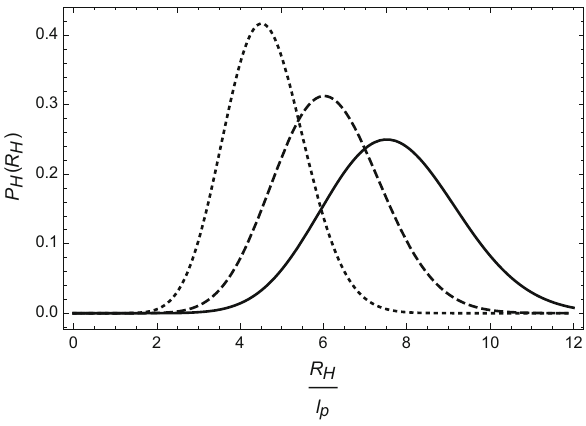
| ψ ( R ) | 2 for the hori- √ H H H 2 m p (cid:11) √ 2 m p (cid:11) 2 . 3 m p (dashed line) and